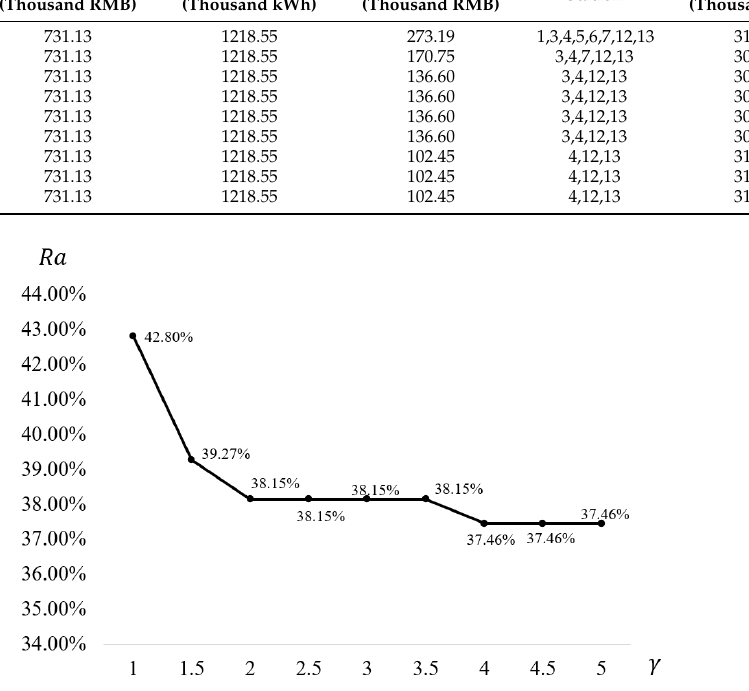
Figure 4. The ratio between the total costs of electric ships and conventional ships under different magnification coefficients of battery capacity. magnification coefficients of battery